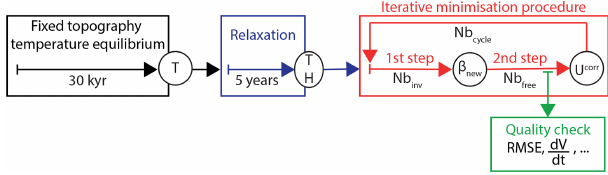
Figure 3. Schematic representation of the iterative minimisation procedure method. The iterative process itself (steps 1 and 2) is shown in the red box. The assessment of the performance of the method for a given cycle (e.g. RMSE and trend discussed in Sects. 4 and 5) is performed at 200 years of the second step (green box), in- dependently of the value of Nb free . The initial conditions for the iterations are the results of the 30000-year temperature computa- tion using a fixed topography (black box) followed by a relaxation of the surface topography (blue